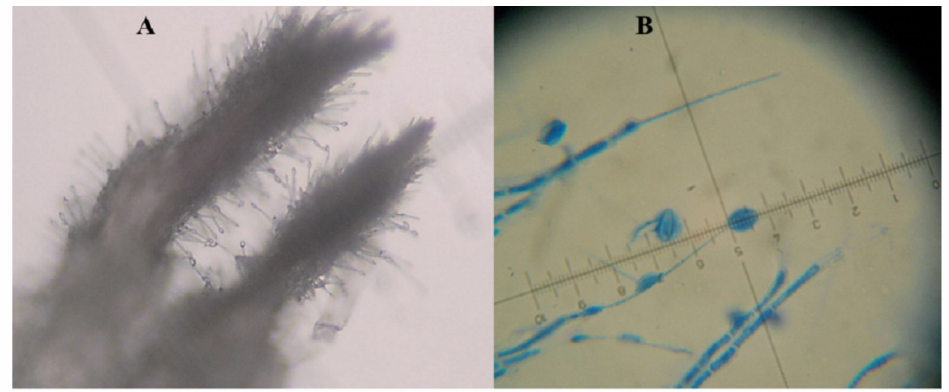
Figure 1. Hirsutella citriformis mycelium structures. ( A ) H. citriformis synnemata developing on Diaphorina citri and ( B ) phialide and conidia. Measurements are in